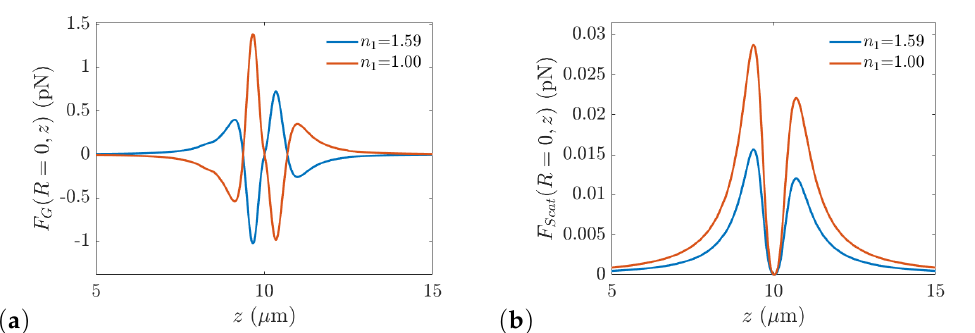
Figure 8. ( a ) z -component of the gradient force and ( b ) scattering force along the beam axis for a dielectric nanoparticle with radius a = 30 nm and having a refractive index n 1 higher (blue line) or lower (red line) than that of the surrounding medium ( n 2 = 1.33). Other parameters are the same as